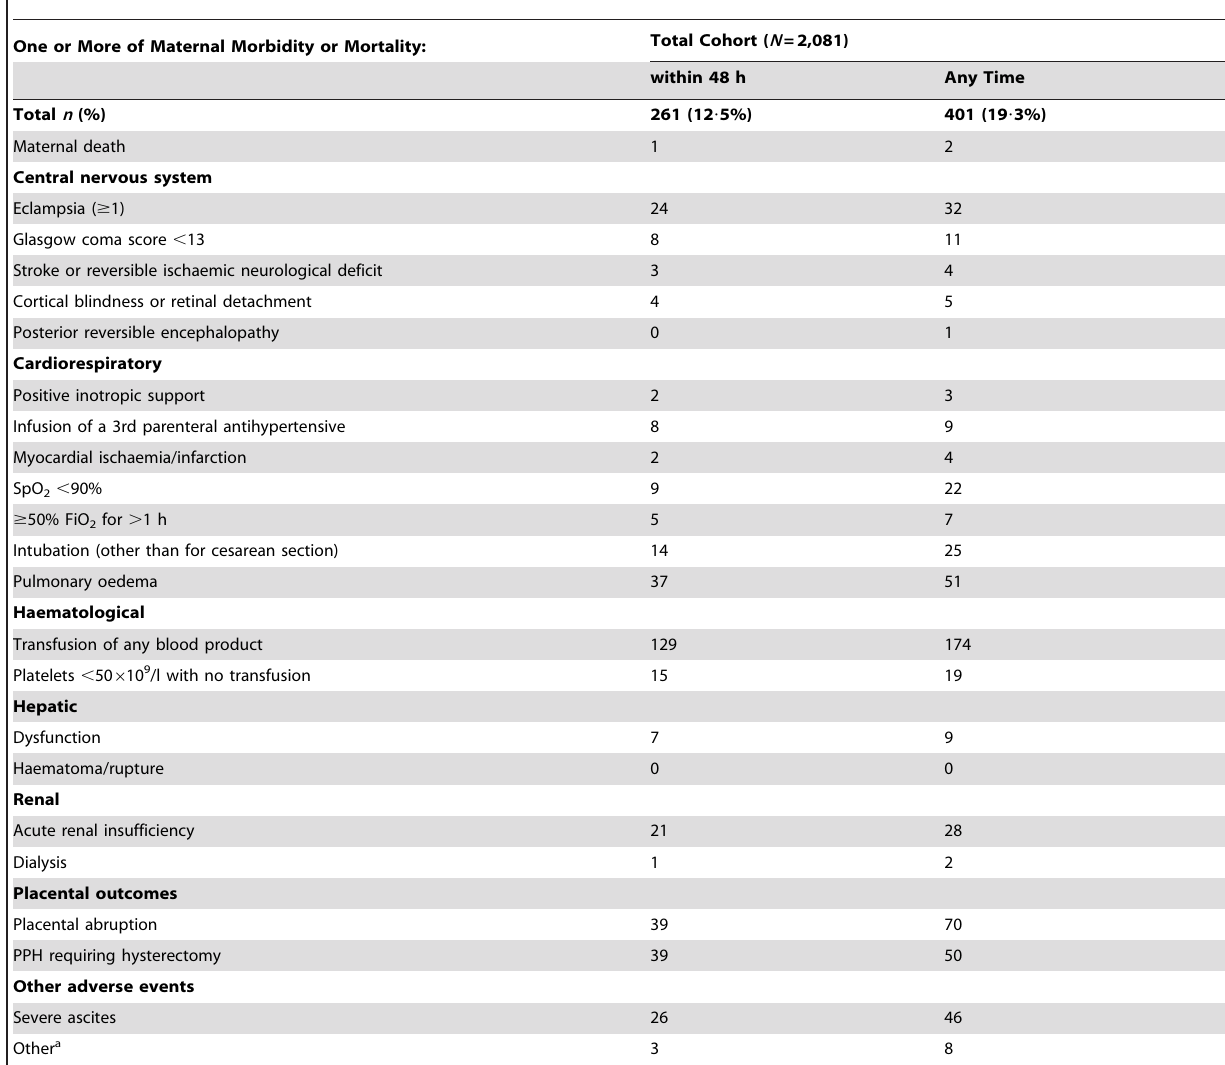
Table 2. Maternal adverse outcomes occurring in the total miniPIERS cohort, outcome counts not mutually exclusive when listed within 48 hours or at any time during